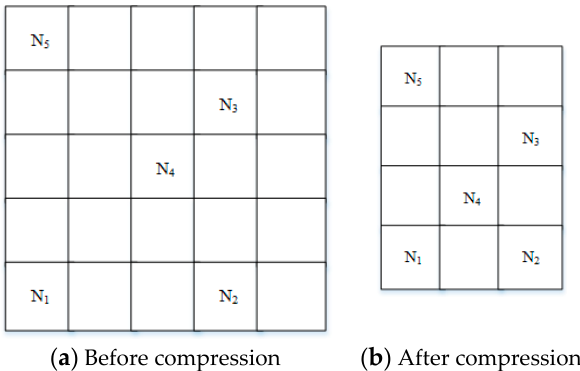
Figure 6. Schematic diagram of map compression.